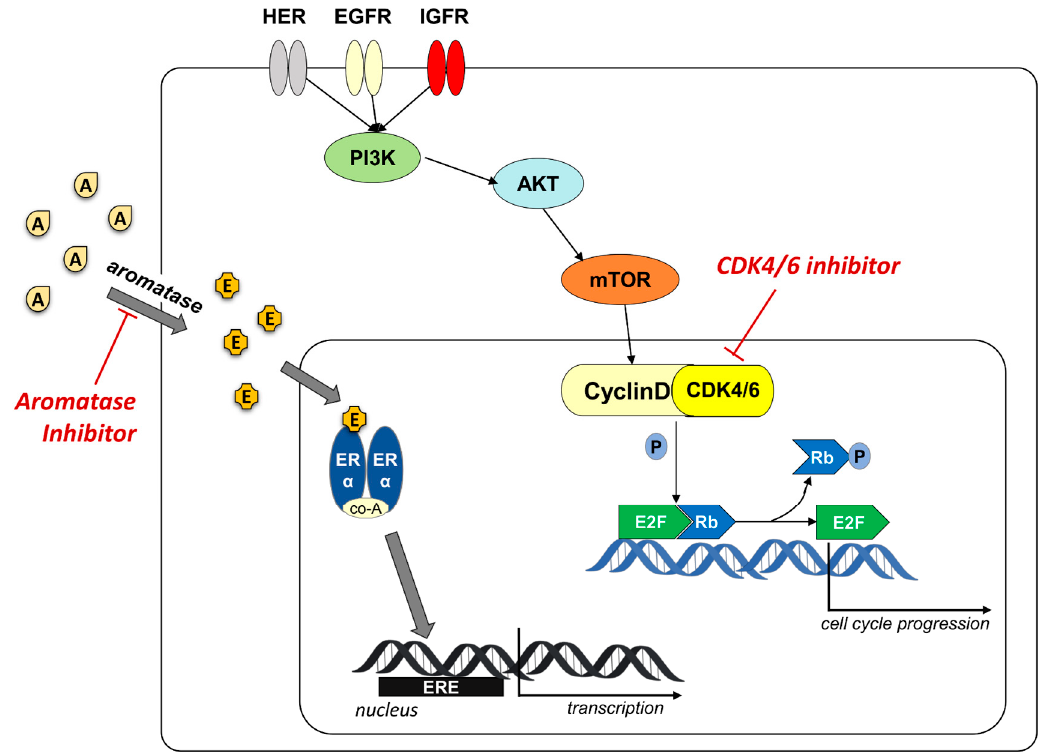
Figure 1. Schematic representation of the cyclinD/CDK4/6 involvement in overpassing resistance to aromatase inhibitors. Aromatase converts androgens (A) in estrogens (E) that bind to ER receptor. The recruitment of co-activators (co-A) allows the binding to ERE element on the target genes and the activation of the transcription. AIs block the production of estrogen inhibiting the ER-driven activation of cell cycle progression. The activation of cyclinD/CDK4/6 complex, mediated by the protein kinase signaling pathway (PI3K/AKT/mTOR), stimulates cell proliferation independently from aromatase. The use of CDK4/6 inhibitor blocks this alternative activation pathway.